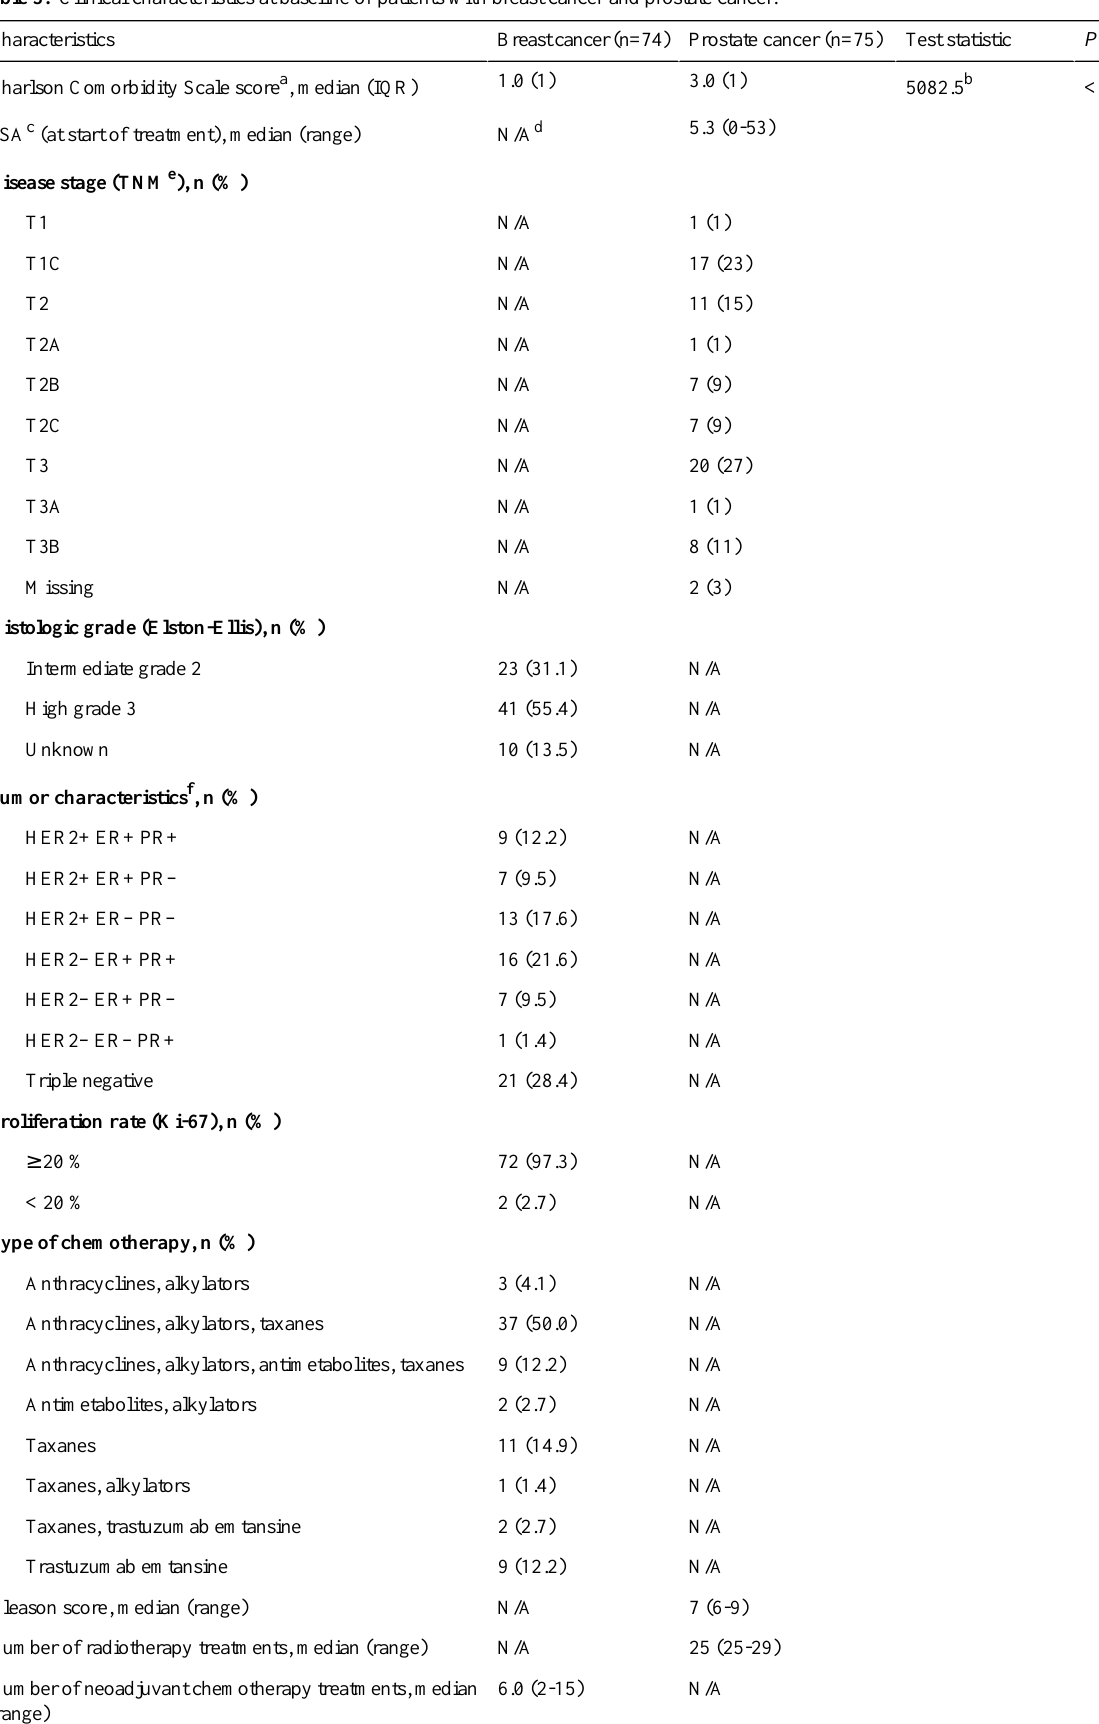
Table 3. Clinical characteristics at baseline of patients with breast cancer and prostate